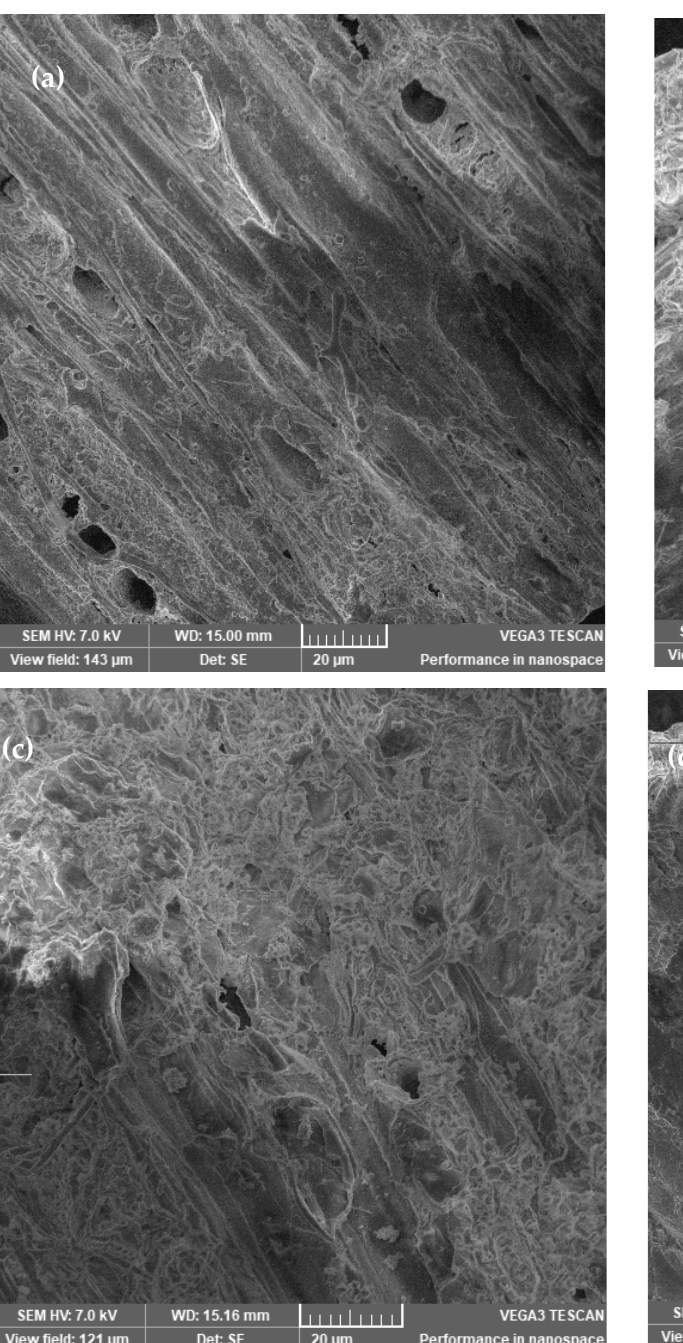
12 of 19 Table 14. Model summary for RSM.